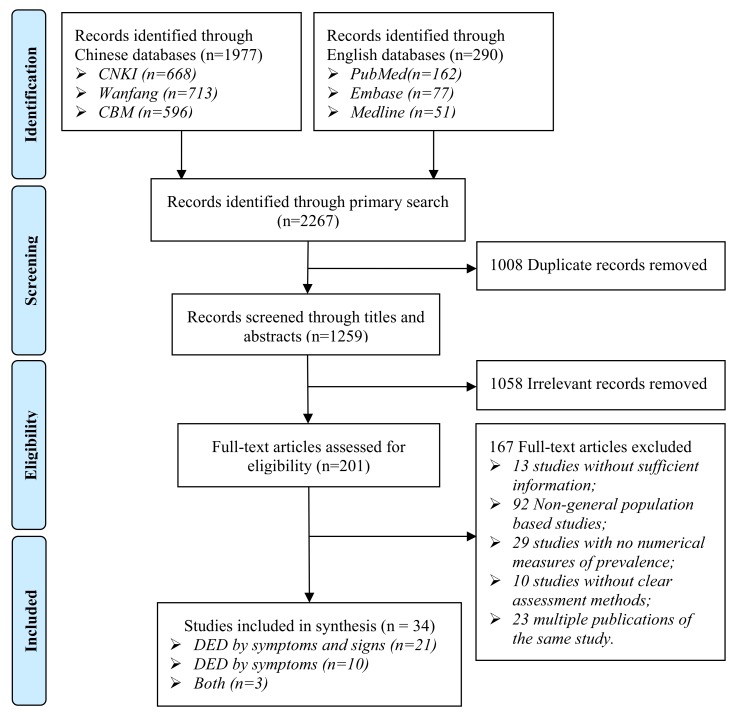
PRISMA of the study selection process.